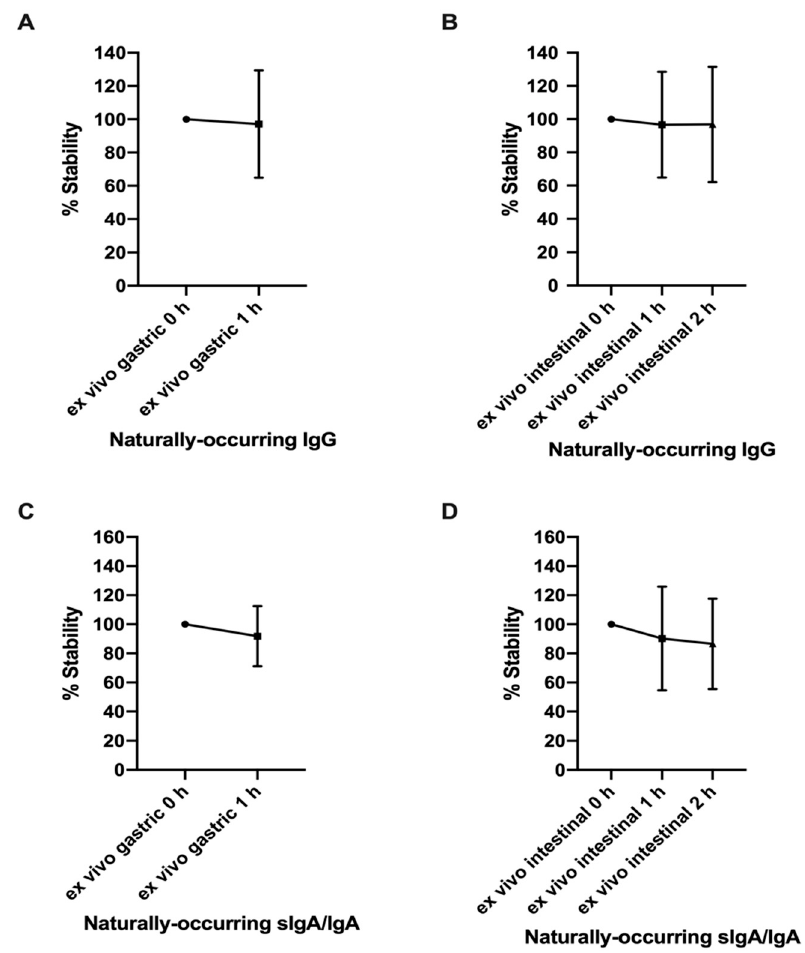
Figure 2. Percentage stability of naturally-occurring IgG and sIgA / IgA across ex vivo infant digestion. ( A ) Percentage stability of naturally-occurring IgG and ( C ) sIgA / IgA across gastric digestion. ( B ) Percentage stability of naturally-occurring IgG and ( D ) sIgA / IgA across intestinal digestion. Values are mean ± SD, n = 12; two infants with two dilutions in triplicate. The unpaired student’s t -tests were used to compare stability between gastric 0 h and 1 h samples. One-way ANOVA followed by Tukey’s multiple comparison tests were used to compare stability among intestinal 0, 1, and 2 h